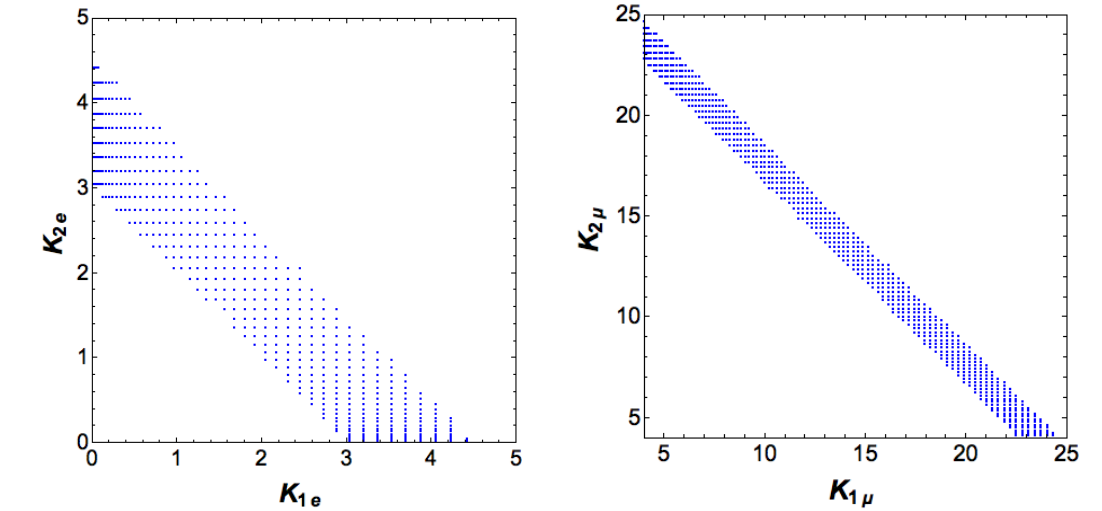
Figure 7 . Flavoured decay parameters for both the RH